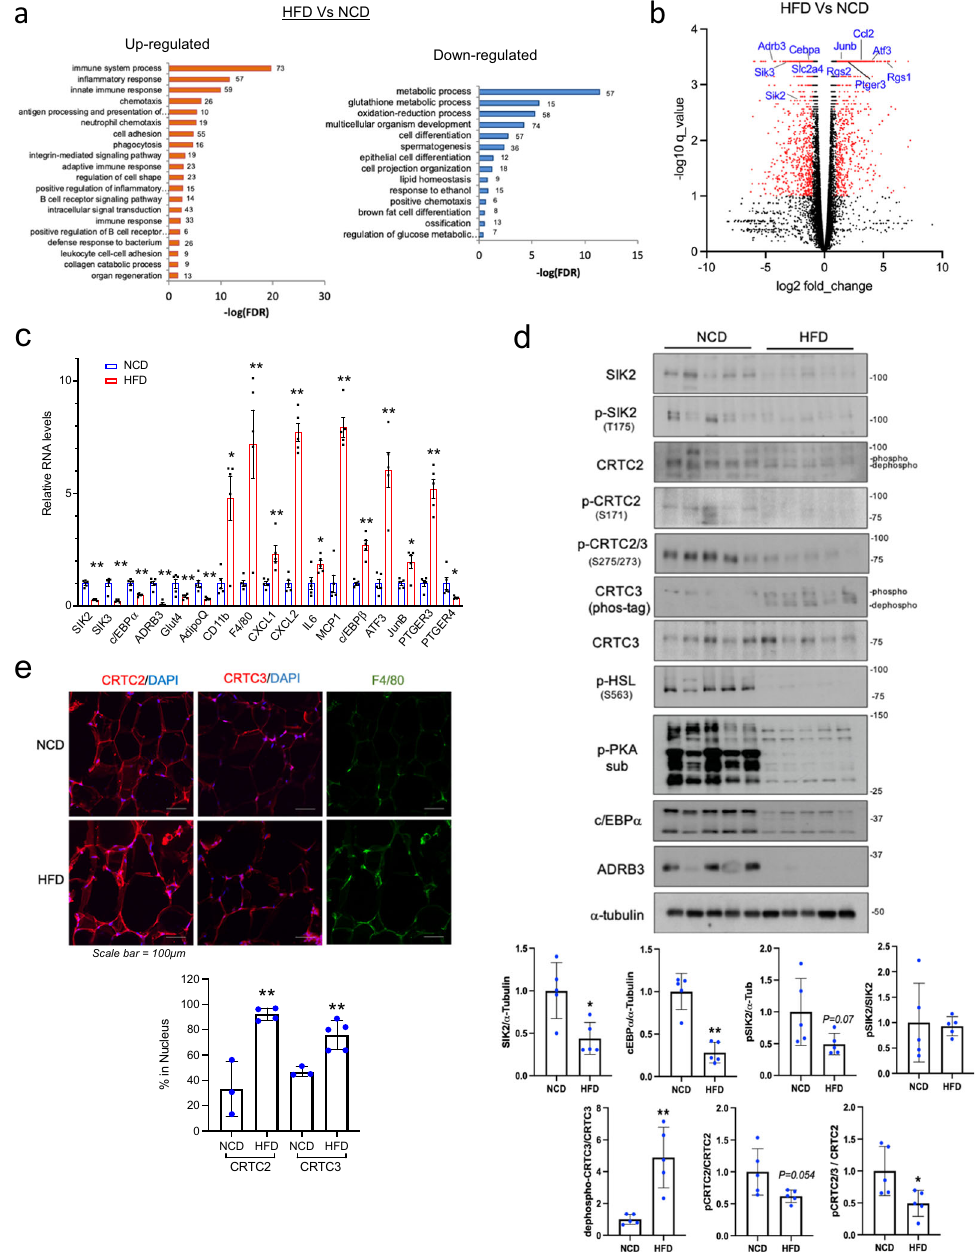
Fig. 1 High fat diet feeding decreases SIK2 expression and activates CRTCs in adipose tissue. a RNA-seq analysis of genes expressed in eWAT from NCD and HFD fed (15 weeks) C57BL/6J mice. 1004 upregulated and 827 downregulated genes in HFD. Gene ontology (GO) of differentially regulated gene clusters shown. The numbers of genes for each GO term indicated. b Volcano plot showing relative effects of high-fat diet (HFD) versus normal